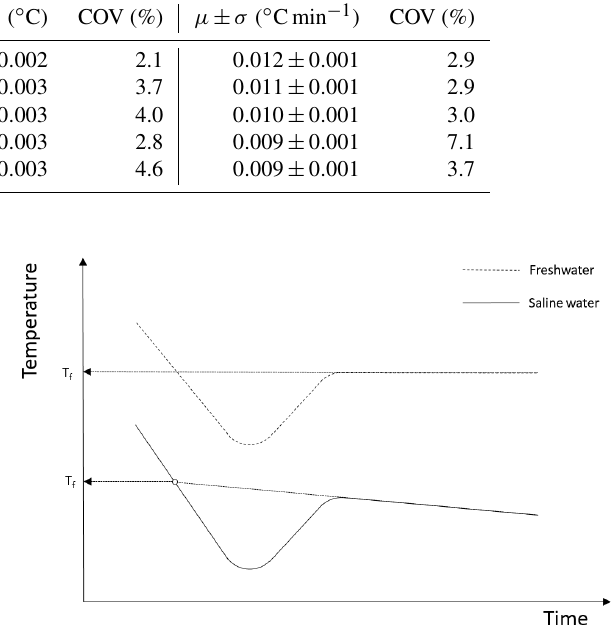
Figure 2. Typical supercooling curves showing the difference be- tween the freezing point temperature T f in freshwater and saline water in a confined vessel. Adapted from She et al.